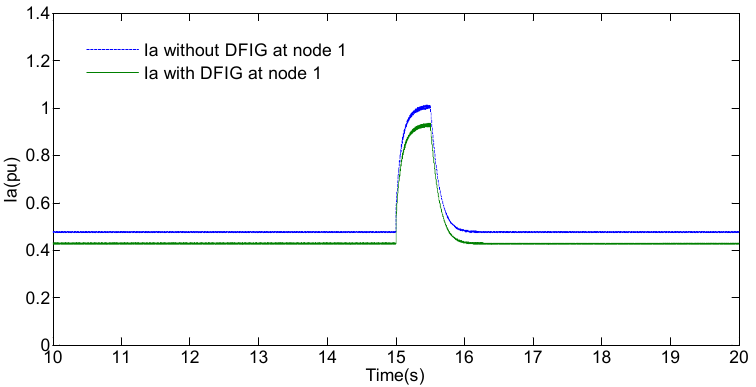
Figure 5. Phase-A currents at node 1 with and without DFIG connected, where an AG fault is applied at node 3.